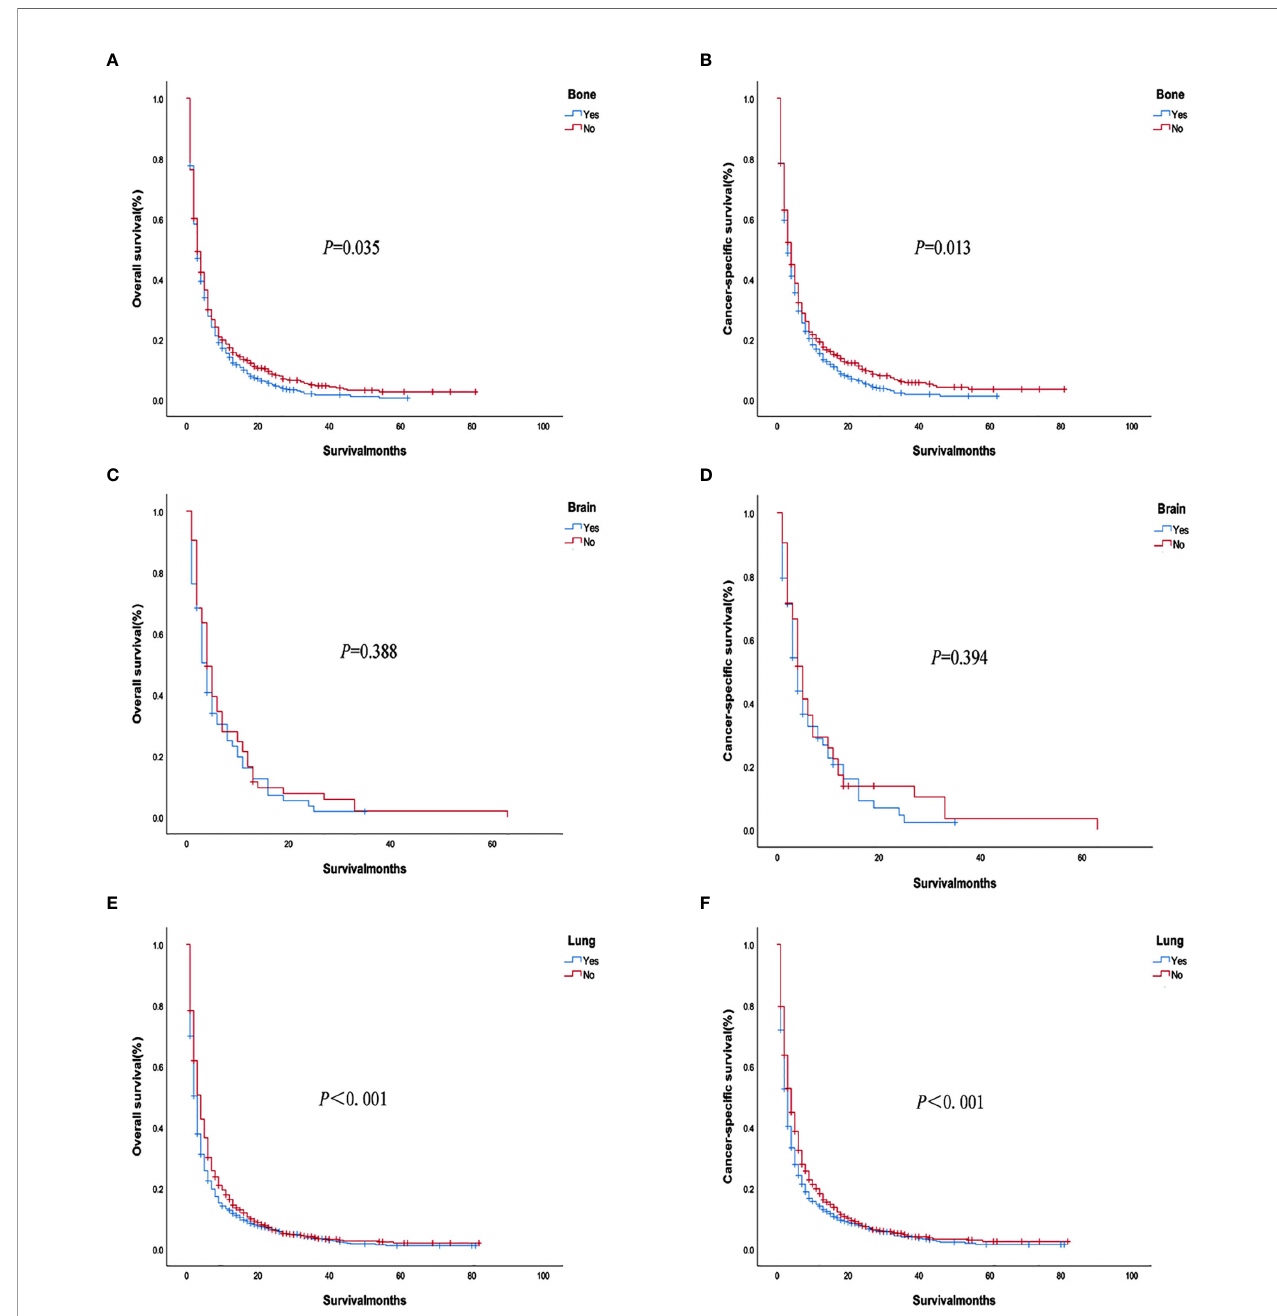
FIGURE 6 | Overall survival and cancer-speci fi c survival curves with or without corresponding organ metastasis after PSM. (A, B) Bone metastasis; (C, D) Brain metastasis; (E, F) Lung